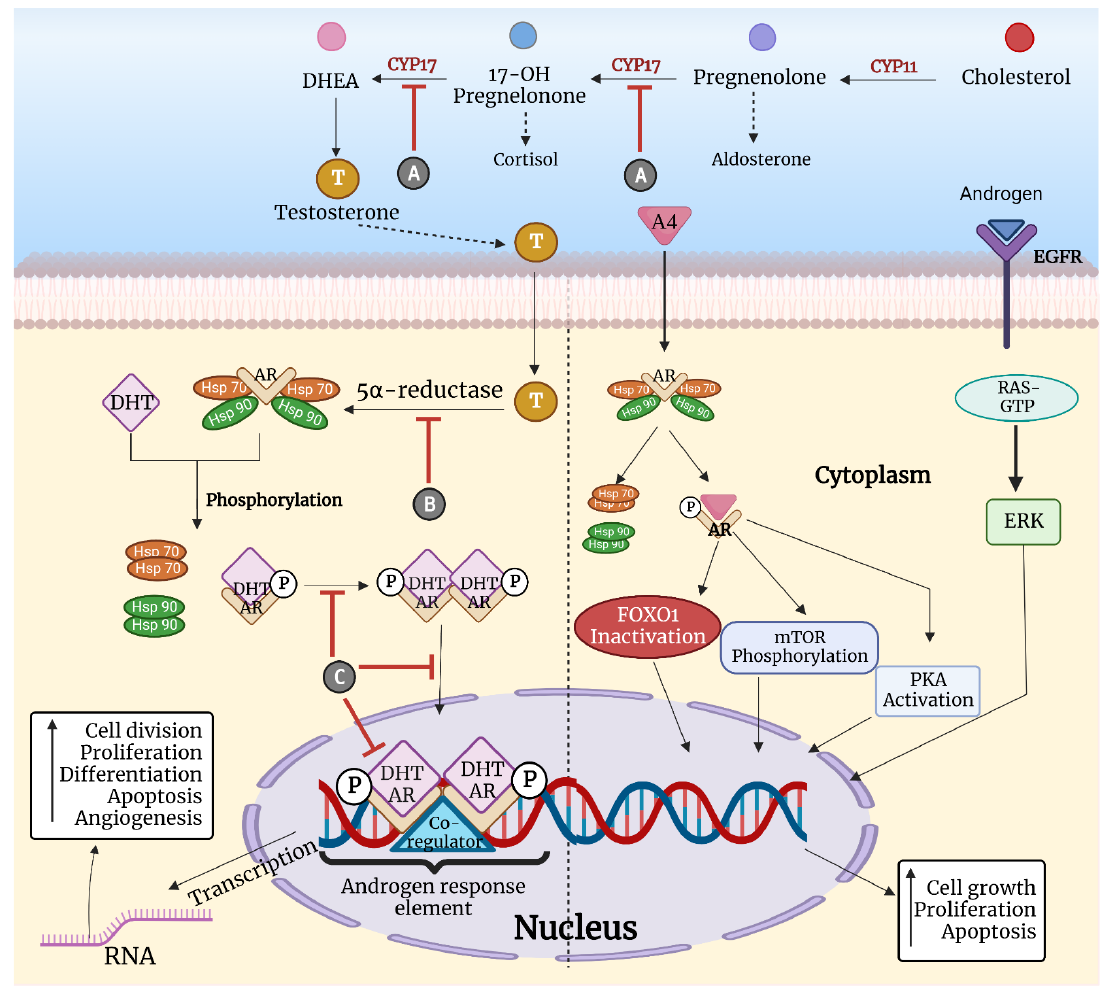
Figure 2. Comprehensive signaling tactics ensuing the activation of androgen receptors along with targeting drug molecules. A: CYP17 inhibitors (Abiraterone, Seviteronel, Orteronel). B: 5 α - reductase inhibitors (dutasteride and finasteride). C: Androgen receptor antagonists (enzalutamide, bicalutamide, apalutamide, darolutamide, seviteronel, enobosarm, CR1447). Cytochrome P450 (CYP), Dehydroepiandrosterone (DHEA), Androgen receptor (AR), Heat shock protein (HSP), Ribonucleic acid (RNA), Forkhead box protein O1 (FOXO1), Mammalian target of rapamycin (mTOR), Protein kinase A (PKA), Extracellular signal-regulated kinase (ERK), Ras active guanosine triphosphate (RAS GTP). Testosterone (T), Dihydrotestosterone (DHT), Androgen receptor (AR), Androgen (A), Bicalutamide